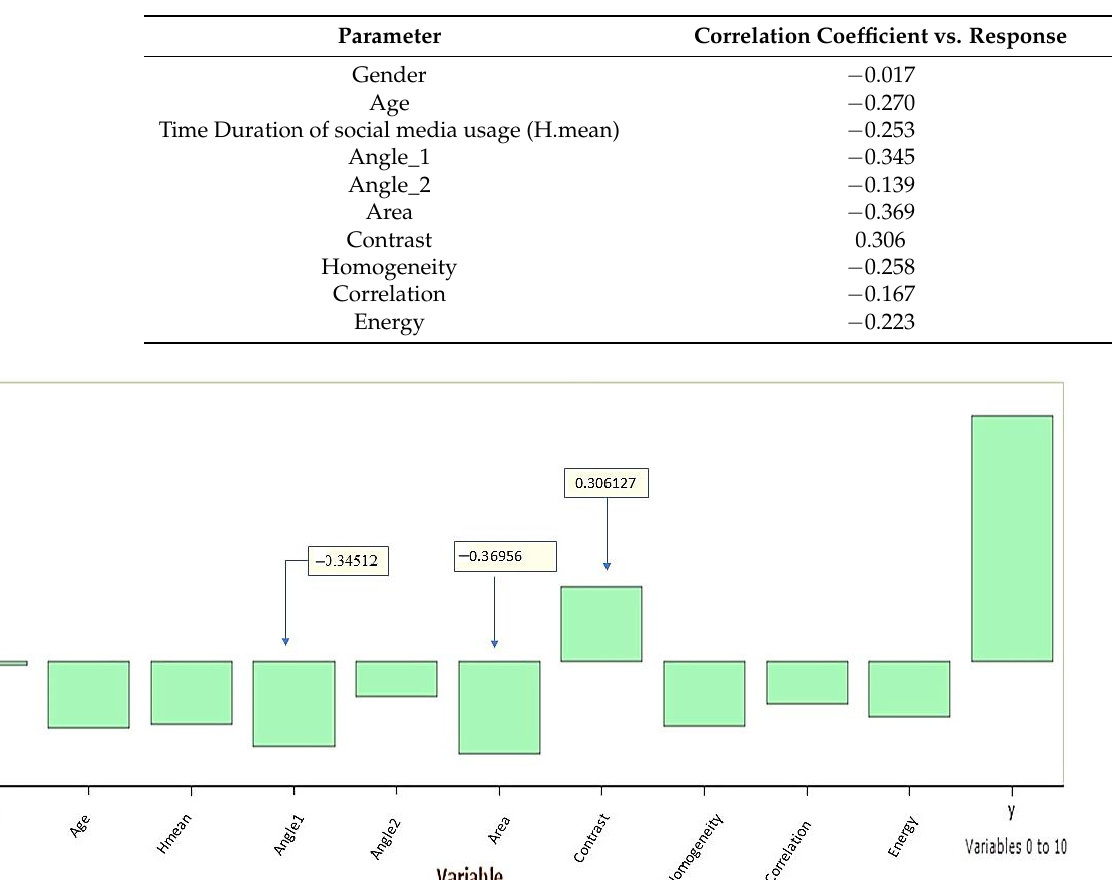
Table 7. Correlation between the variables and responses related to the neck condition.